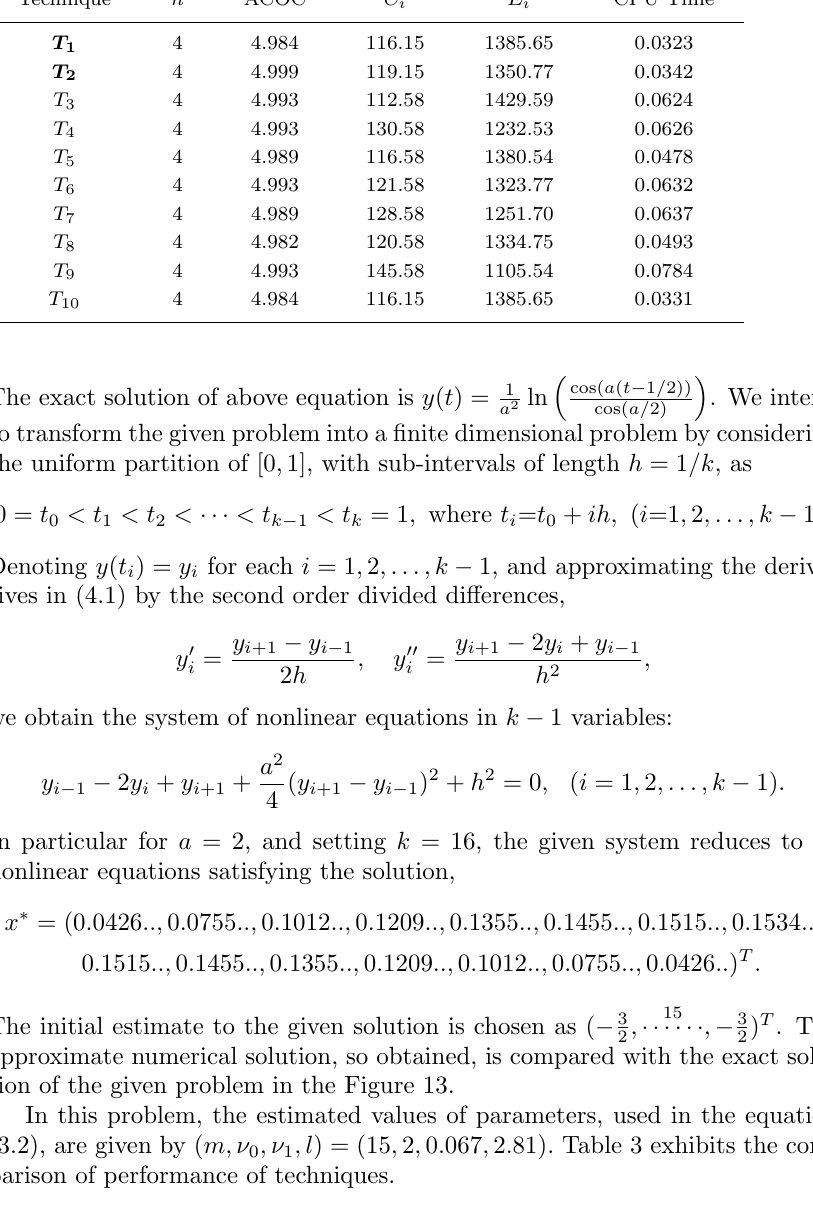
Table 2. Comparison of performance of techniques for Problem 1.